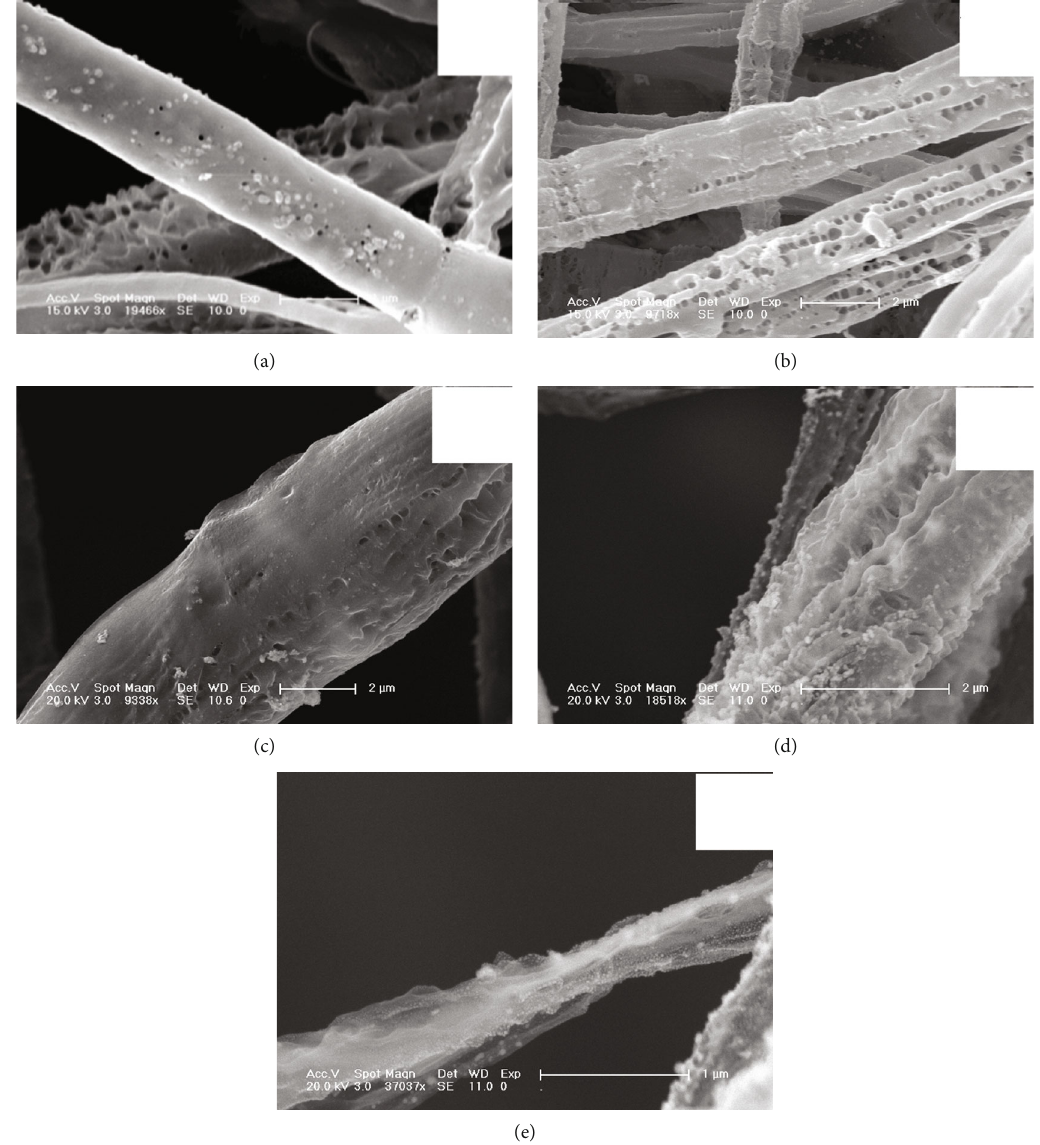
Figure 4: Scanning electron micrographs of the electrospun Ag/POM/ β -CD micro fi bers with di ff erent contents of β -CDs: (a) 10 wt.% β - CDs, (b) 20wt.% β -CDs, (c) 30wt.% β -CDs, (d) 40wt.% β -CDs, and (e) 50 wt.% β